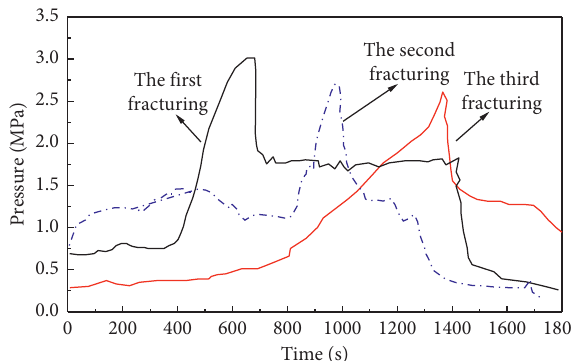
Figure 6: Variations in water injection pressure during each hydraulic fracturing.